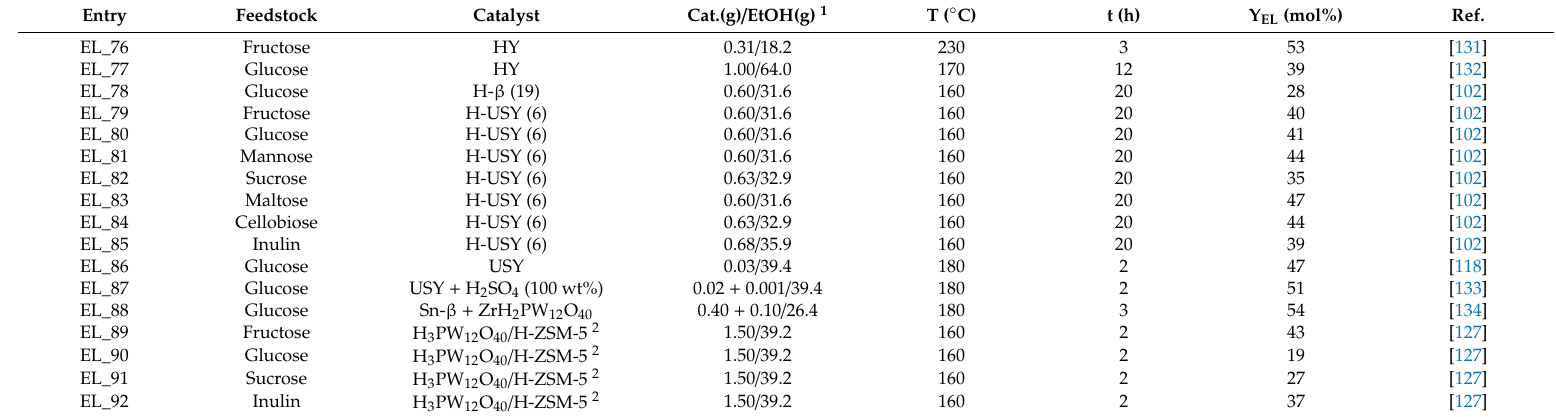
Table 10. Zeolite-based catalysts for the EL production from C6 model carbohydrates, under conventional